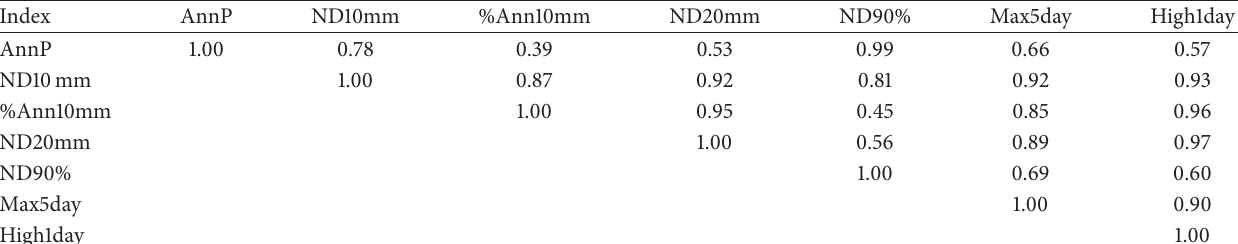
Table 2: Pearson product-moment correlation coefficients amount the indices of extreme precipitation.